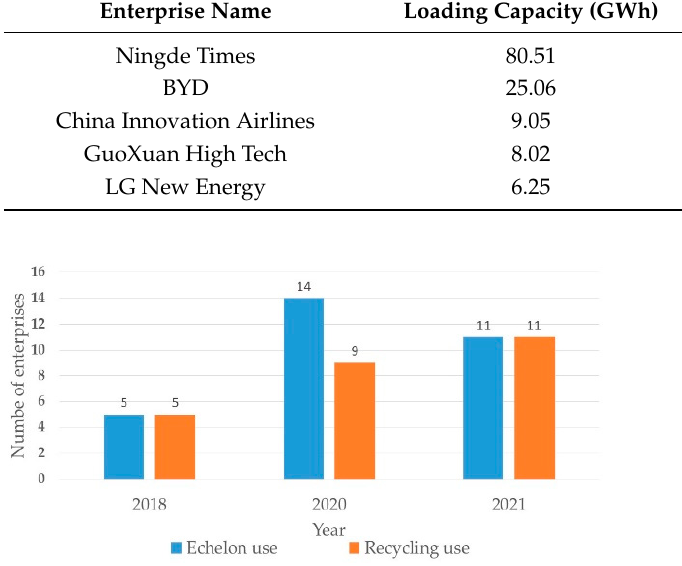
Figure 1. Number of echelon utilization and recycling enterprises.